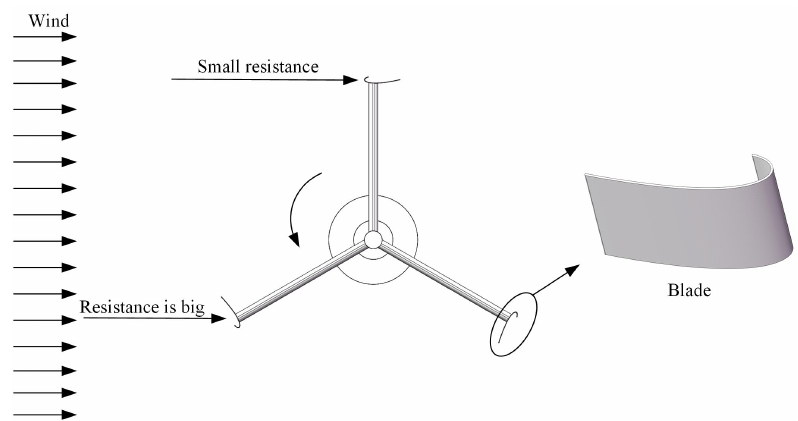
Figure 5. J-blade vertical axis offshore wind turbine.